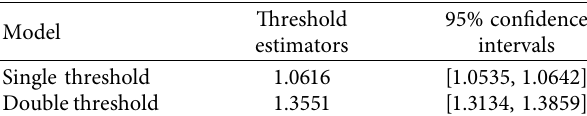
respectively. Table 3: The threshold value and confidence intervals.